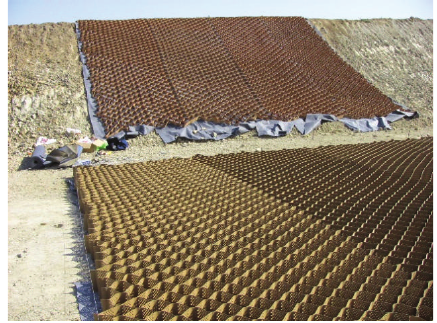
Figure 1: Application of geocell in the field.